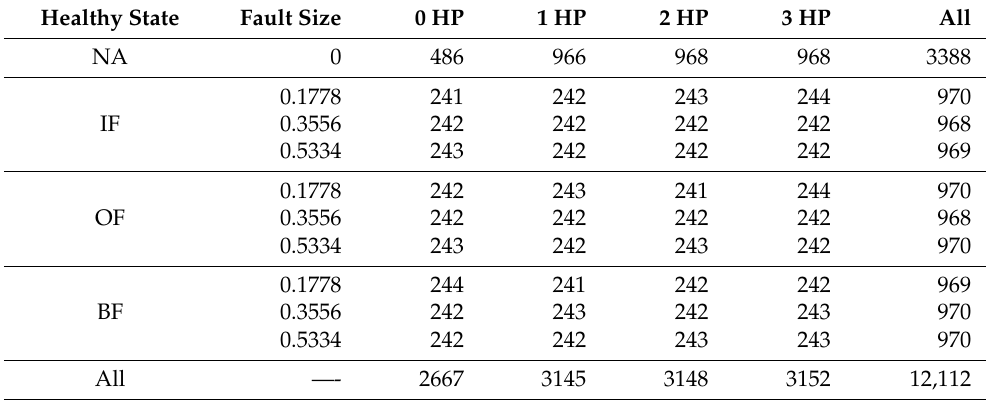
Table 2. The CWRU sample size scale.